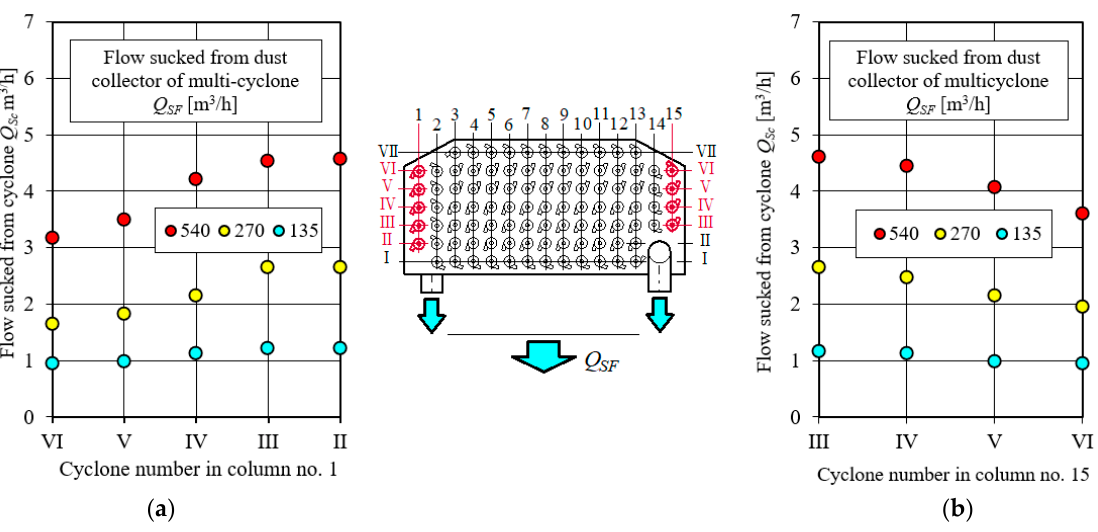
Energies 2021 , 14 , x FOR PEER REVIEW Figure 25. The values of the sucked flows Q Sc from the cyclones of the seventh (VII) row of the MT multicyclone.